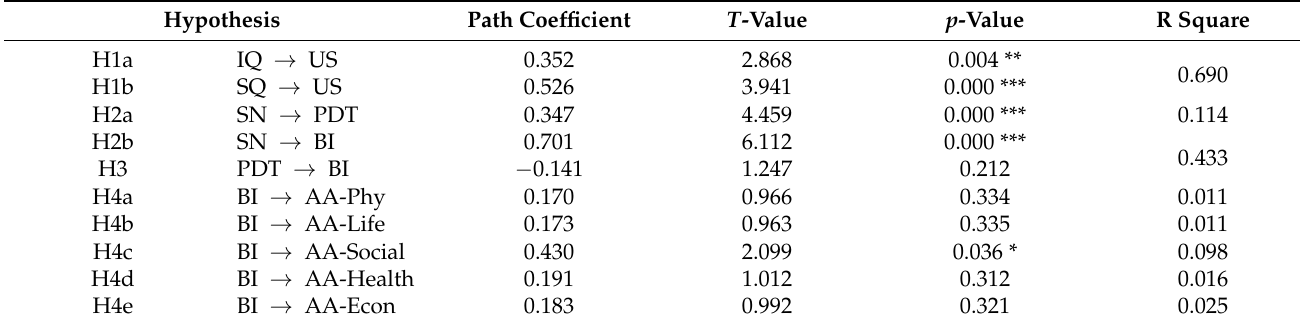
Table 5. Path analysis results list.